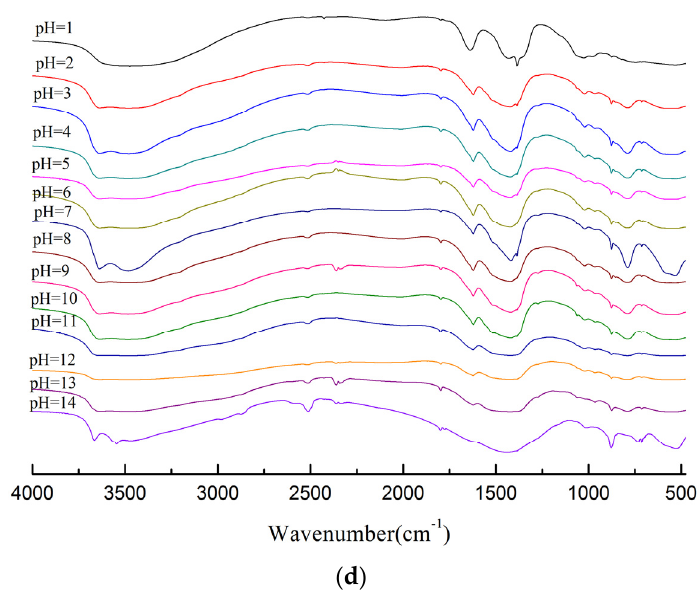
Figure 5. Stability analysis of calcium chloroaluminate. ( a ) SEM of calcium chloroaluminate. ( b ) Curve of chloride ion release concentration in solution. ( c ) XRD of calcium chloroaluminate in solid phase under different pH conditions. ( d ) FT-IR spectrum of the solid phase of calcium chloroaluminate at different pH.